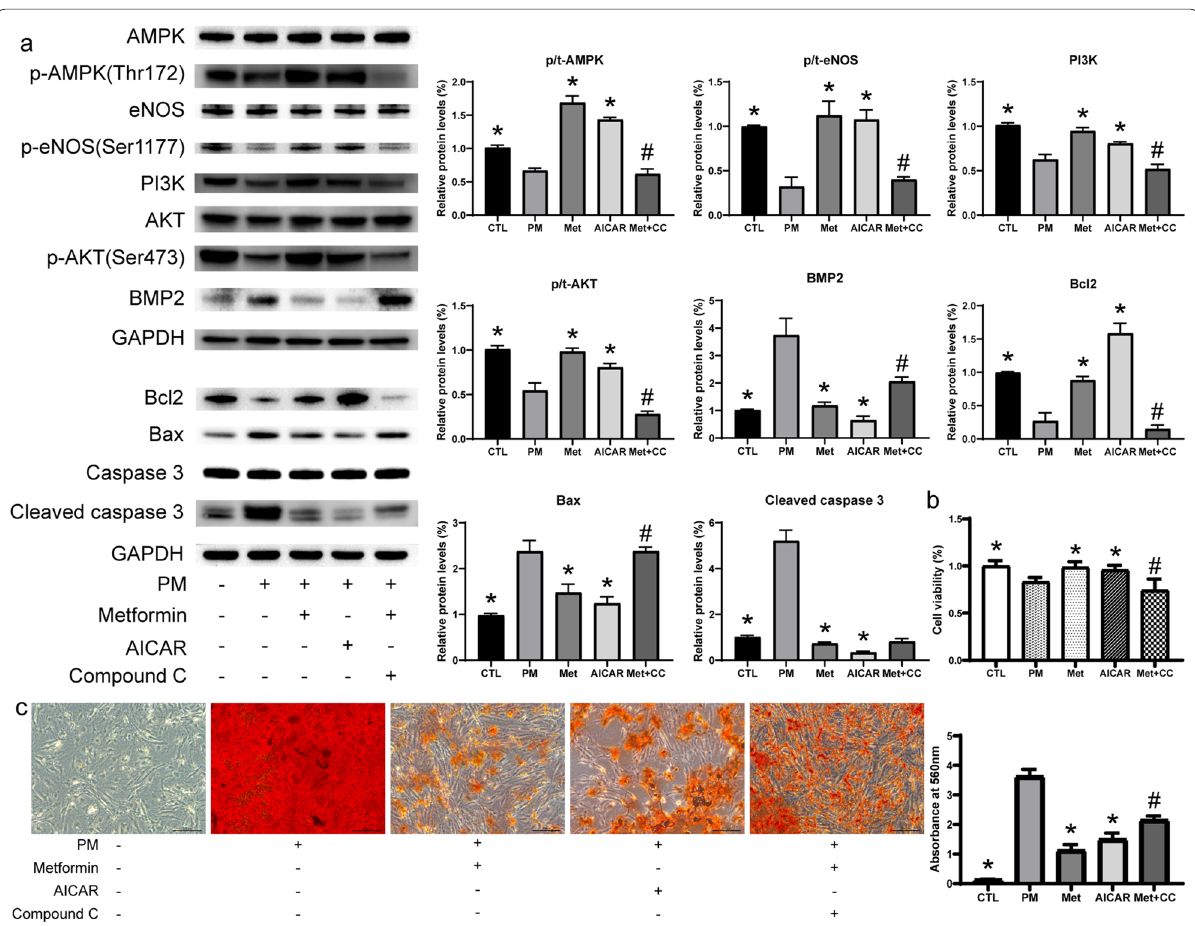
Fig. 5 AMPK inhibitor ameliorates the anti-calcification and anti-apoptosis effect of metformin on AVICs. a Protein expression levels of the PI3K/ AKT and apoptosis pathway in AVICs after various treatments with metformin (100 μM), AMPK activator (AICAR, 500 μM), and AMPK inhibitor (Compound C, CC, 10 μM) for 72 h as determined by WB; b cell viability was detected by CCK8 after various treatments for 72 h; c calcium deposition were detected by ARS Staining after various treatments for 7 days, Scale bar, 200 μm. n 6 per group. CTL control; PM phosphate = medium; Met metformin; *p < 0.05 versus PM group; # p < 0.05 versus Met group (one-way ANOVA with Bonferroni post hoc